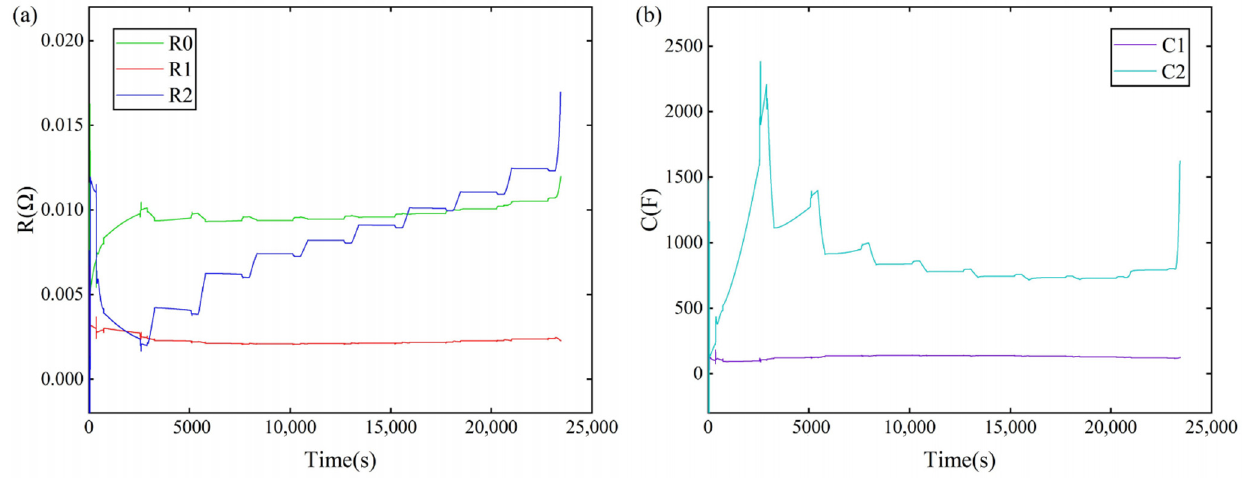
Figure 2. ( a ) 𝑅 (cid:2868) , 𝑅 (cid:2869) , 𝑅 (cid:2870) parameter identification results; ( b ) 𝐶 (cid:2869) , 𝐶 (cid:2870) parameter identification re-